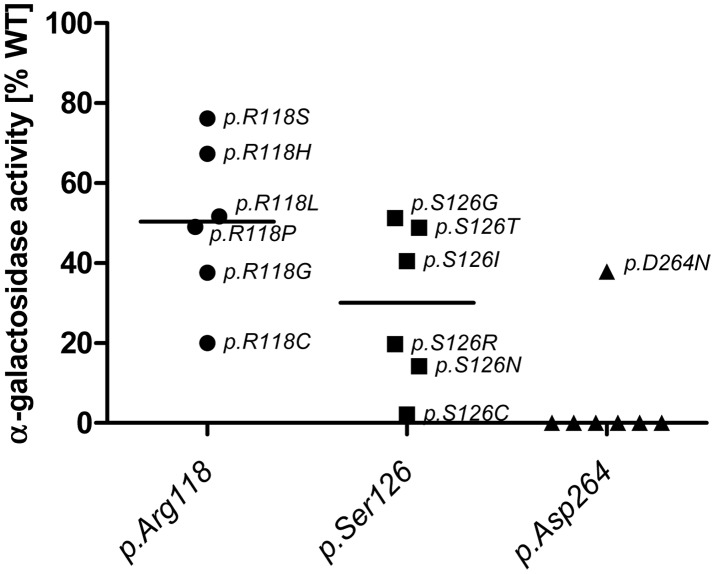

In vitro activity of specific GLA site mutations.Note that mutations at position p.Asp264 almost always lead to a loss of GLA activity, while the same does not hold true for p.Arg118 and p.Ser126. Interestingly mutations in p.R118 do not lead to a loss of activity below 20% of WT and range from 20% to 80% while p.Ser126 can lose all activity with certain mutations and retains no more than 60% activity. This highlights the differential effects of the mutational site and amino acid change on α-Gal A activity. Given is the median activity of all mutations in each position (horizontal mark).